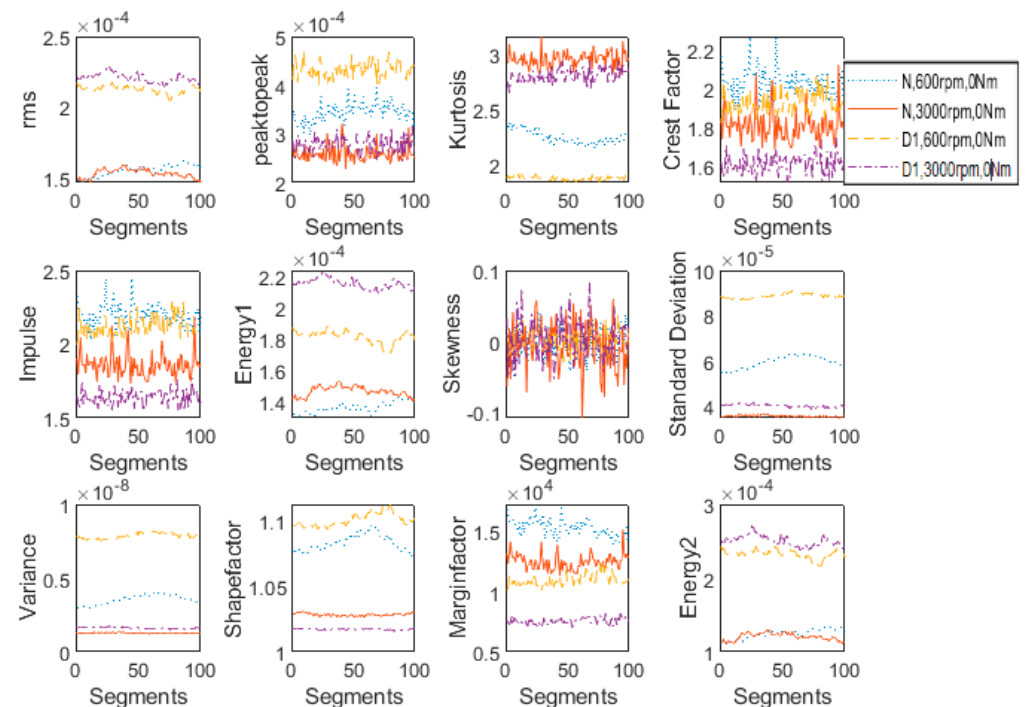
Figure 7. Features’ plot for normal and 1 tooth broken gear boxes at constant load (0 Nm) and changing speed (600 and 3000 rpm).